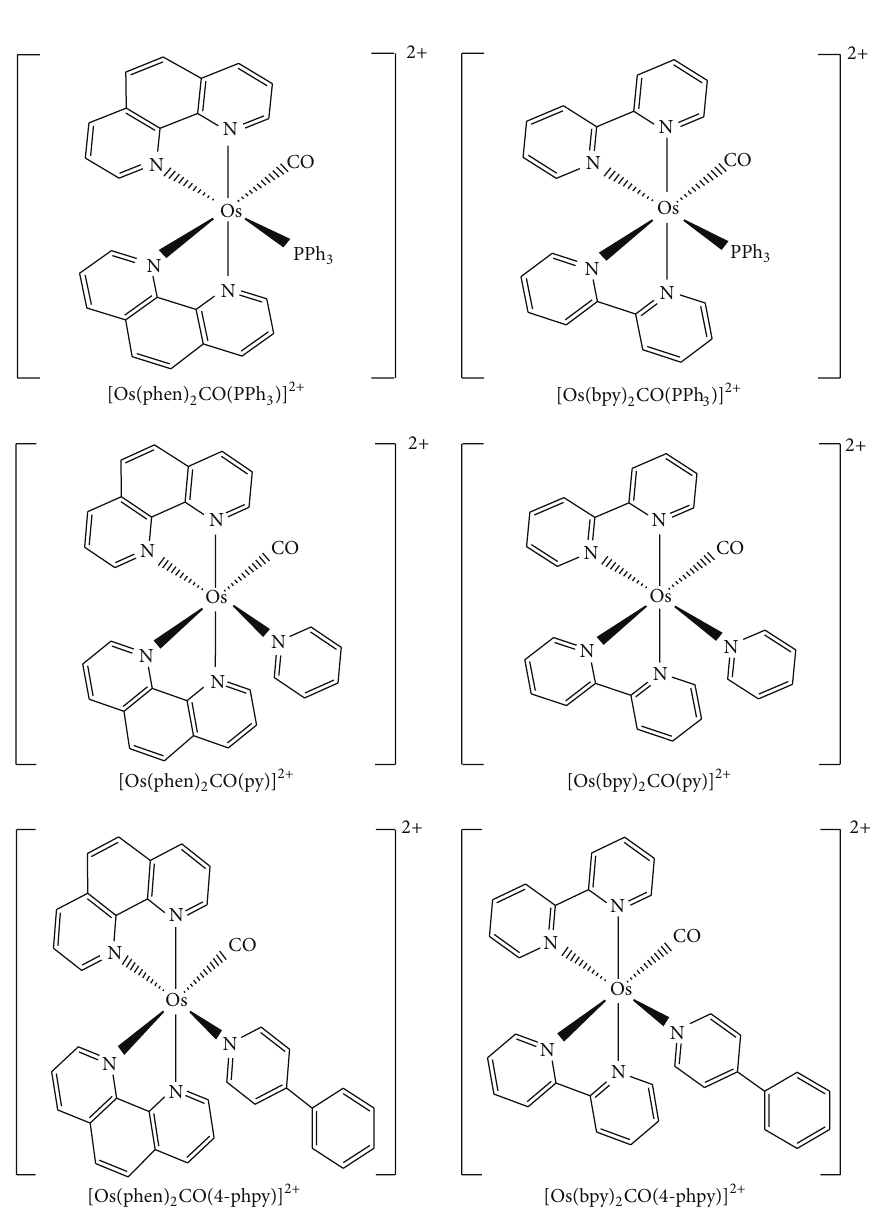
Figure 1: Structures of the six osmium